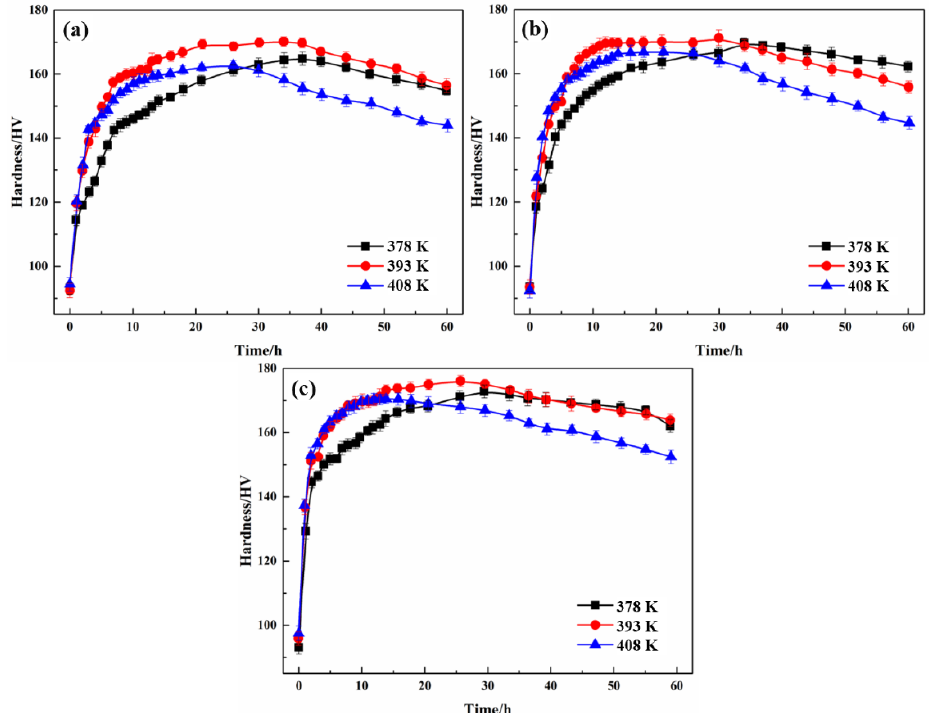
Figure 1. Age-hardening curves of Al-5Zn-2.6Mg-xCu alloys at different temperatures: ( a ) x = 0.24 wt.%, ( b ) x = 0.43 wt.%, and ( c ) x = 0.91 wt.%. Table 2. Peak hardness and aging time of Al-5Zn-2.6Mg-xCu alloy. Aging